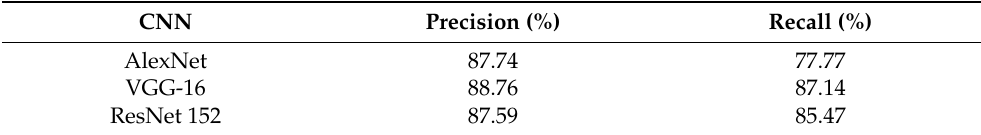
Table 5. Comparison of the well-known CNN